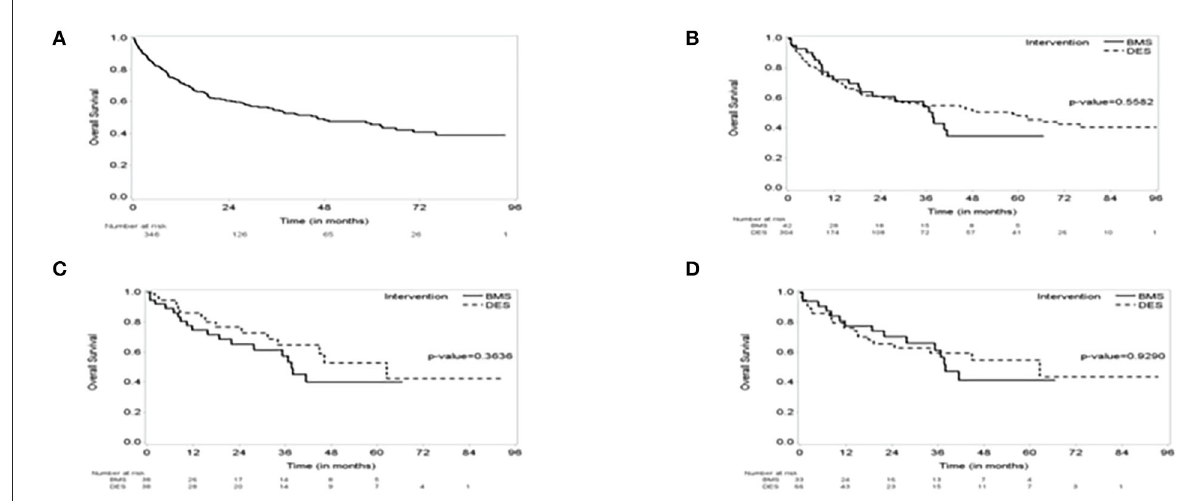
FIGURE1 The Kaplan–Meier (KM) survival curve. (A) The KM curve of the entire group showing Median survival: 46 months (95% CI, 34–66); median follow-up of 34 months (95% CI, 28–39). (B) KM Survival curve by intervention showing no difference in survival over the follow-up period between bare metal stent (BMS) vs. drug-eluting stent (DES). (C) a 1:1 propensity score-matched cohorts of BMS vs. DES showing no difference in survival. (D) a 1:2 propensity score-matched cohorts of BMS vs. DES showing no difference in survival.